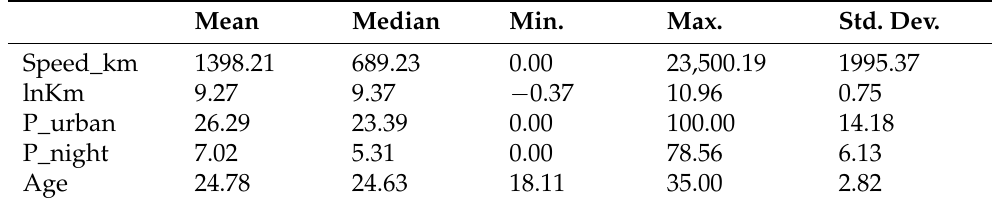
Table 2. Descriptive analysis of the continuous variables in the telematics data set for 2010 ( n = 9618). Mean Median Min.